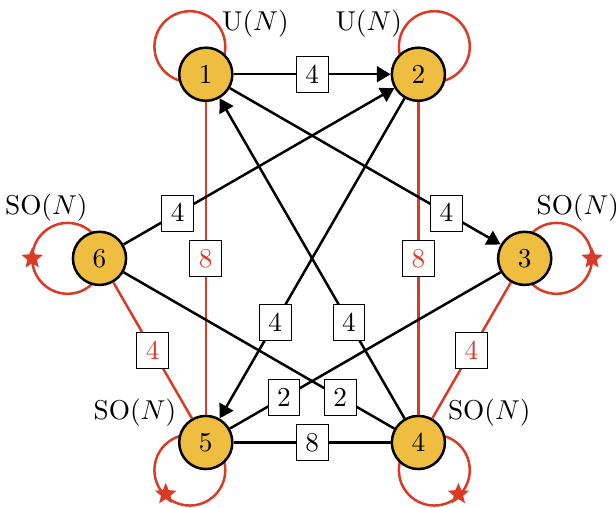
Figure 32 . Quiver diagram for the Spin(7) orientifold of phase L of Q 1 , 1 , 1 / Z 2 using the involution in eqs. (C.20), (C.21) and (C.22), together with our choice of γ